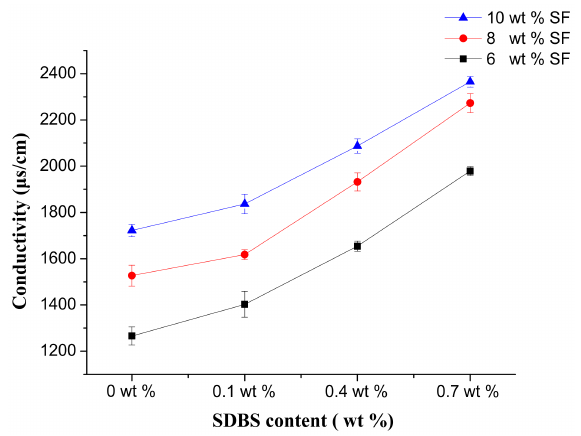
Figure 4. Conductivity of the spinning